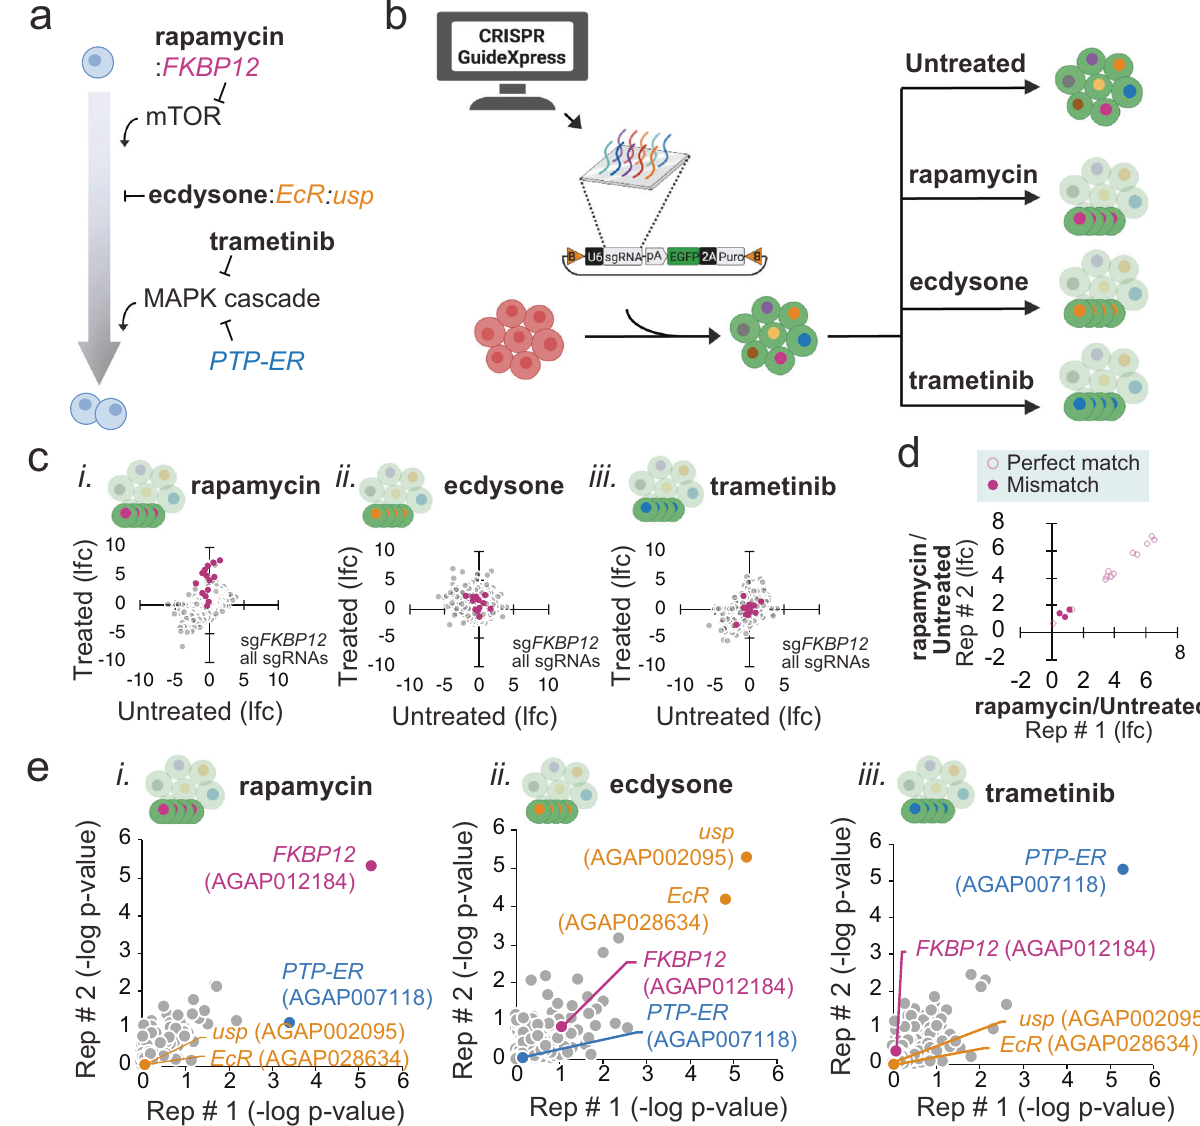
Fig. 5 Pilot pooled CRISPR drug resistance screens in Anopheles cells. a Schematic of proliferation-related pathways used to validate the screening approach. Rapamycin binding to FKBP12 inhibits mTOR, which is necessary for proliferation. Ecdysone binding to EcR and Usp inhibits proliferation. Trametinib inhibits the mitogen-activated protein kinase (MAPK) signaling cascade, which normally promotes proliferation. PTP-ER is a potent endogenous negative regulator of MAPK. b We used CRISPR GuideXpress to design a library of 3487 sgRNAs against mosquito orthologs of FKBP12, EcR, usp , and PTP- ER . These were cloned into a library donor vector (pLib6.4-Agam-695) and integrated into Sua-5B-IE8-Act::Cas9-2A-Neo cells. The cells were left untreated or treated with the indicated drugs. c Endpoint sgRNA readcounts compared to plasmid readcounts show that more than half of all FKBP12 sgRNAs were enriched following growth in rapamycin but not ecdysone or trametinib. d FKBP12 sgRNAs predicted to target the reference genome, AgamP4, but with mismatches as compared to the Sua-5B-IE8-Act::Cas9-2A-Neo genome failed to enrich following rapamycin treatment. e Robust rank aggregation (RRA) analysis of sgRNA readcount data from all screens shows that FKBP12 was selectively enriched after rapamycin treatment, EcR and usp were selectively enriched after ecdysone treatment, and PTP-ER was selectively enriched in trametinib treatment (two biological replicates). Source data are provided as a Source Data fi le. Raw data can be found in Supplementary Data 3.